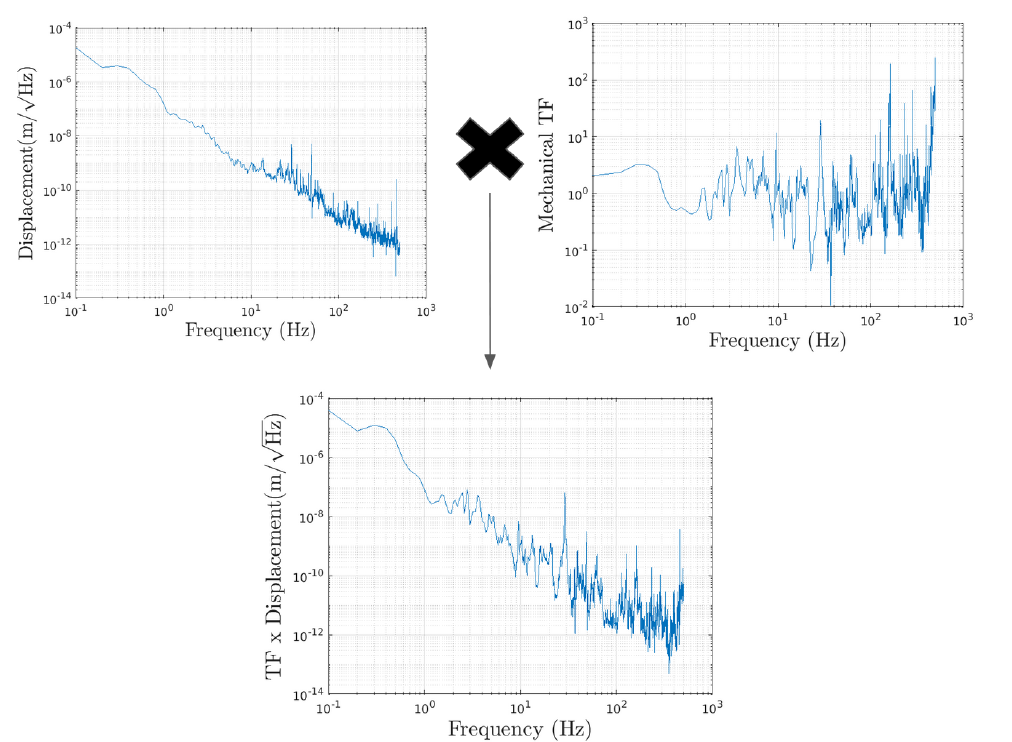
Figure 9. ( Top left corner ) Combination of the accelerometer and velocimeter data presented in Figure 8. ( Top right corner ) Mechanical TF from the tube to the cryobaffle. ( Bottom ) Final cryobaffle displacement, obtained by multiplying the accelerometer plus velocimeter data by the cryobaffle mechanical